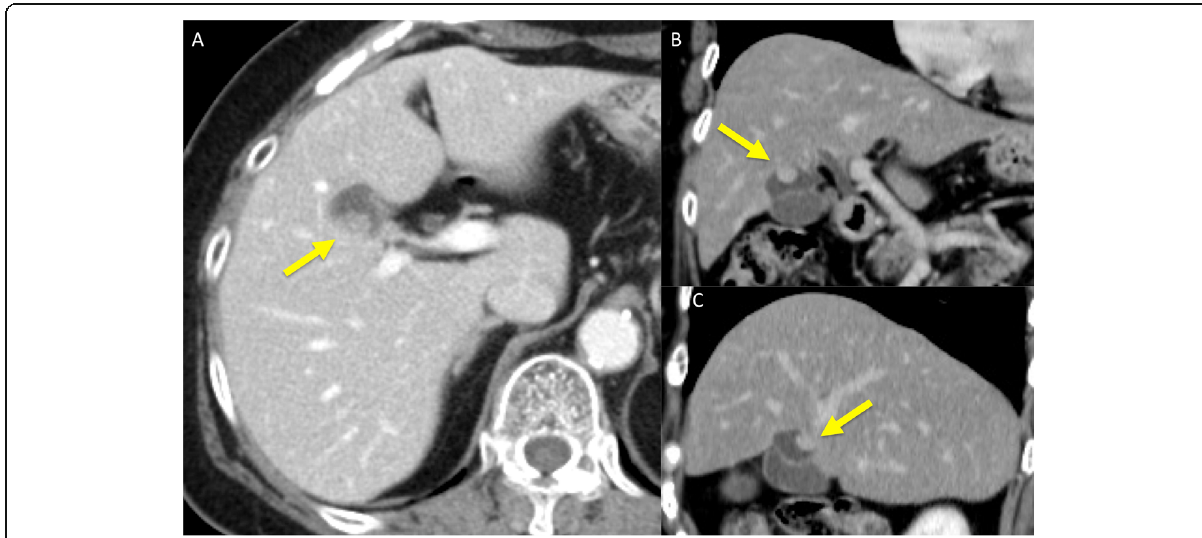
Fig. 2 Abdominal enhanced CT imaging. Carcinoma in the proximal gallbladder, which was identified as the accessory gallbladder, shown by enhanced CT images. a Axial view. The low-density mass with a diameter of 1 cm was slightly enhanced (see the arrows). Direct liver invasion was less conspicuous on CT imaging. b Coronal view, and c sagittal view. Two separate cavities were clearly demonstrated